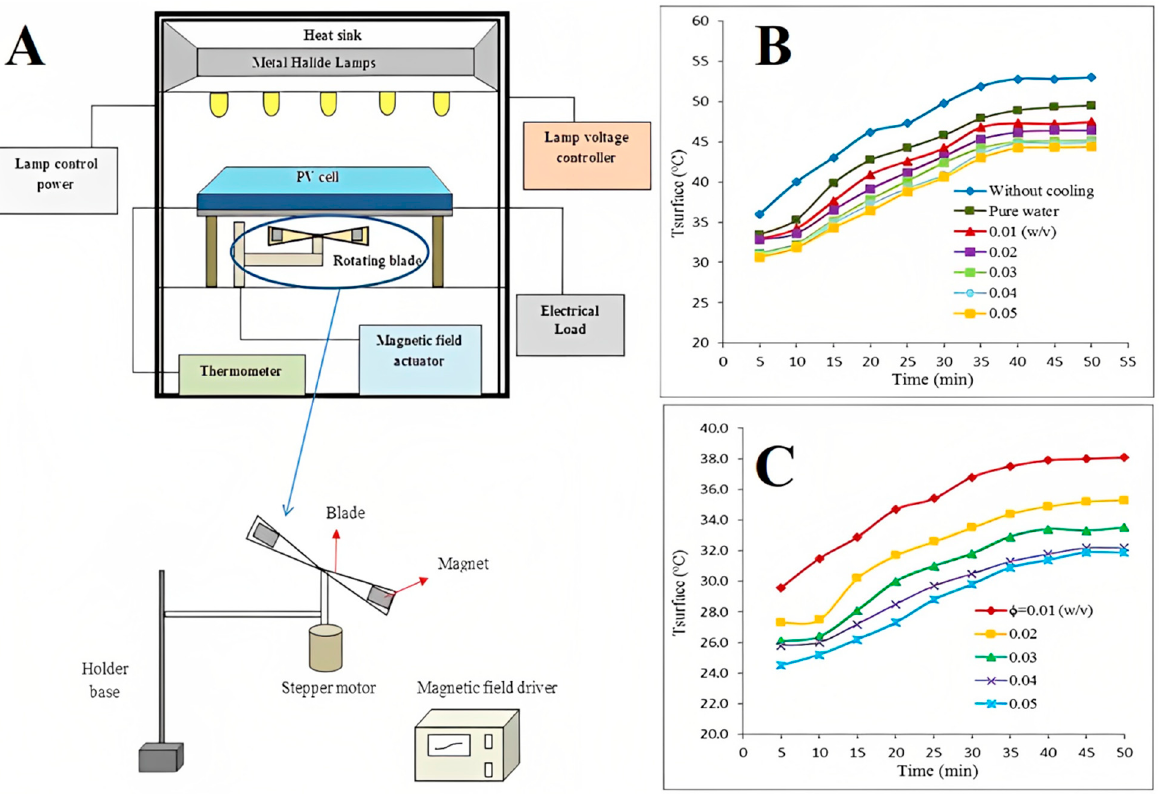
Figure 12. ( A ) Schematic diagram of experimental setup; variation of the average temperature of the PV cell surface overtime ( B ) without RMF and ( C ) with RMF with B=880 mT and ω =8 rad/s. Reprinted with permission from Ref. [116]. Copyright 2018, Elsevier.